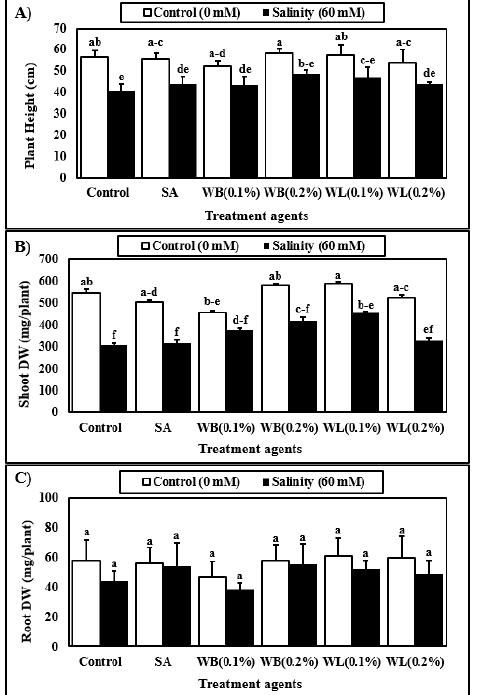
Figure 3. Effect of treatments with various agents (SA, salicylic acid (25 µM); WB, willow bark extract (0.1% or 0.2% w/v ); WL, willow leaf extract (0.1% or 0.2% w/v )) on plant height ( A ), shoot dry weight (DW) ( B ), root dry weight (DW) ( C ) of 30-day-old maize ( Zea mays cv. Caramelo) plants hydroponically grown in control (0 mM) or salinity stress (60 mM) conditions. Reported data are means of 4 independent biological replicates. Different letters indicate significant differences between means according to Tukey’s HSD test ( p < 0.05). For two-way ANOVA results and the HSD scores used to separate the means, see Table